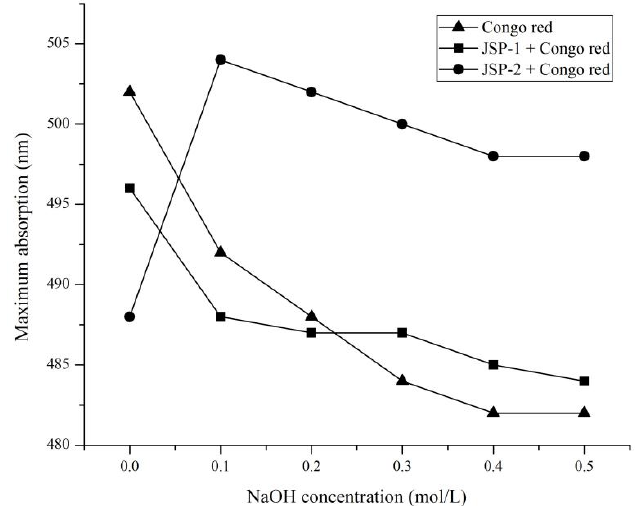
Figure 5. Analysis of triple helical conformation of JSP-1 and JSP-2.